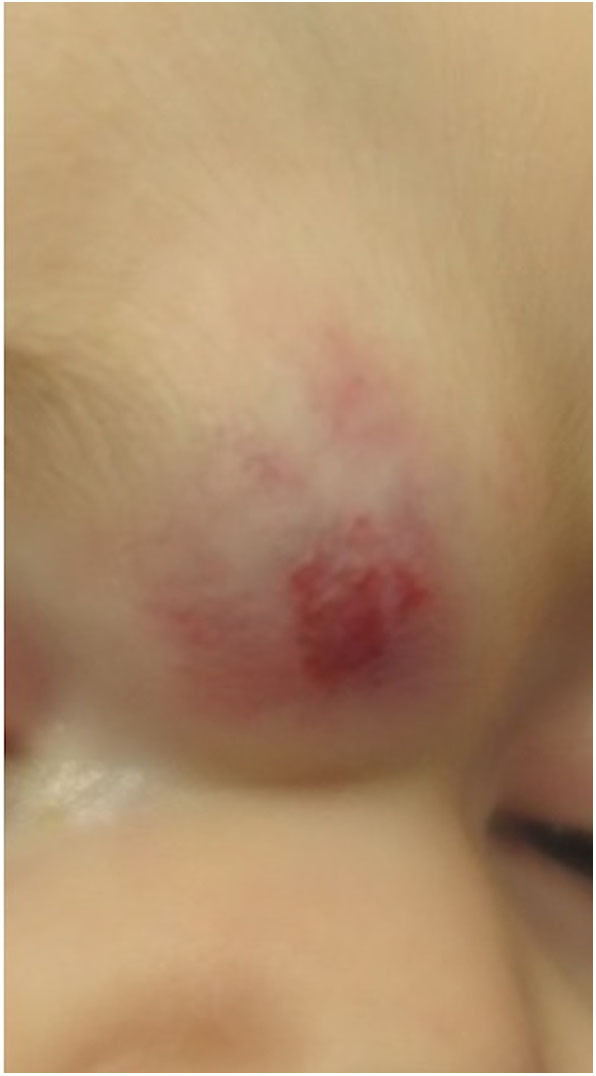
Compound infantile hemangioma of the glabella in a 5 month old infant.